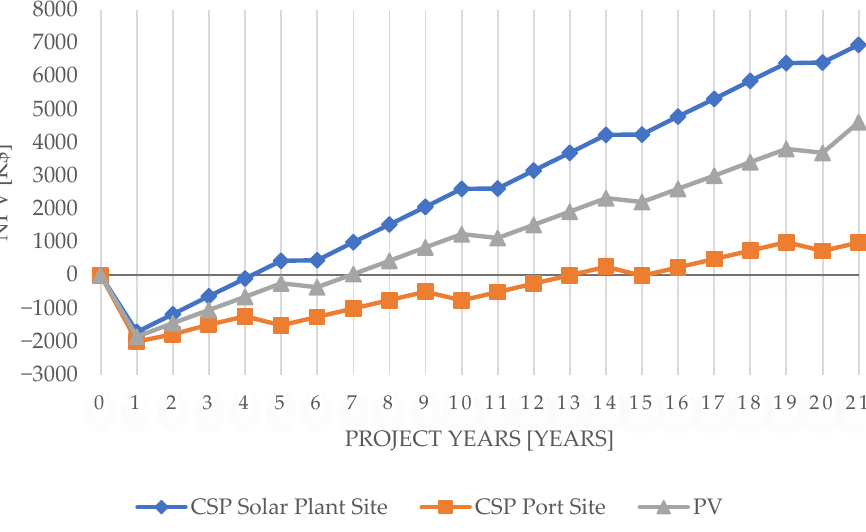
Figure 6. NPV variations for all hydrogen production plants in all scenarios.